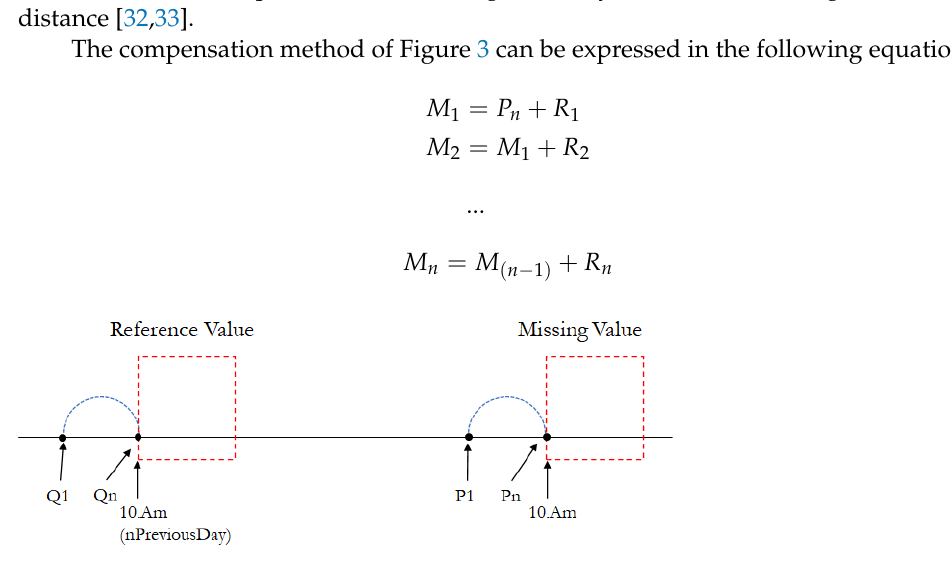
Figure 3. Similar-past-situation